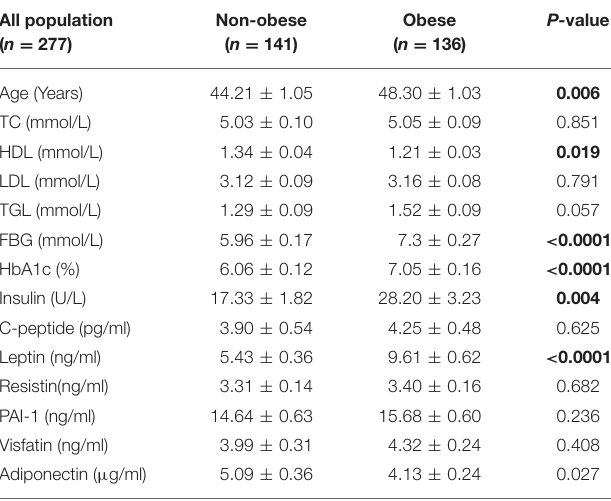
TABLE 1 | Physical and biochemical characteristics of the whole study population categorized based on obesity. All population ( n =